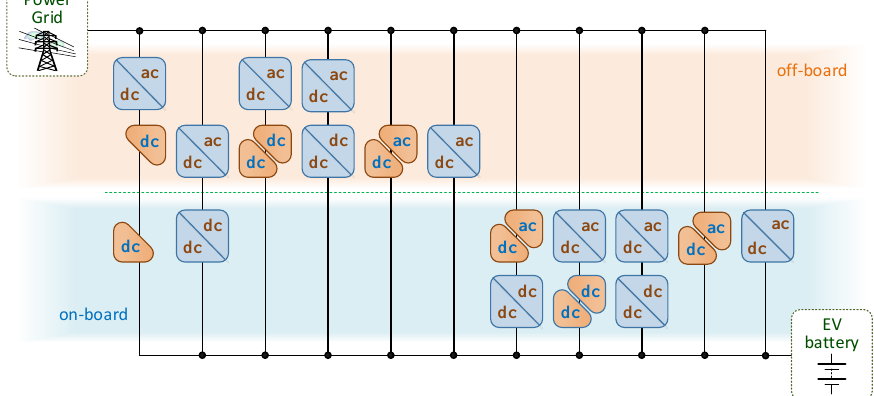
Figure 1. Classification of different structures for on-board and off-board electric vehicle (EV) battery chargers based on single or double power electronics stages. Energies 2020 , 13 , x FOR PEER REVIEW